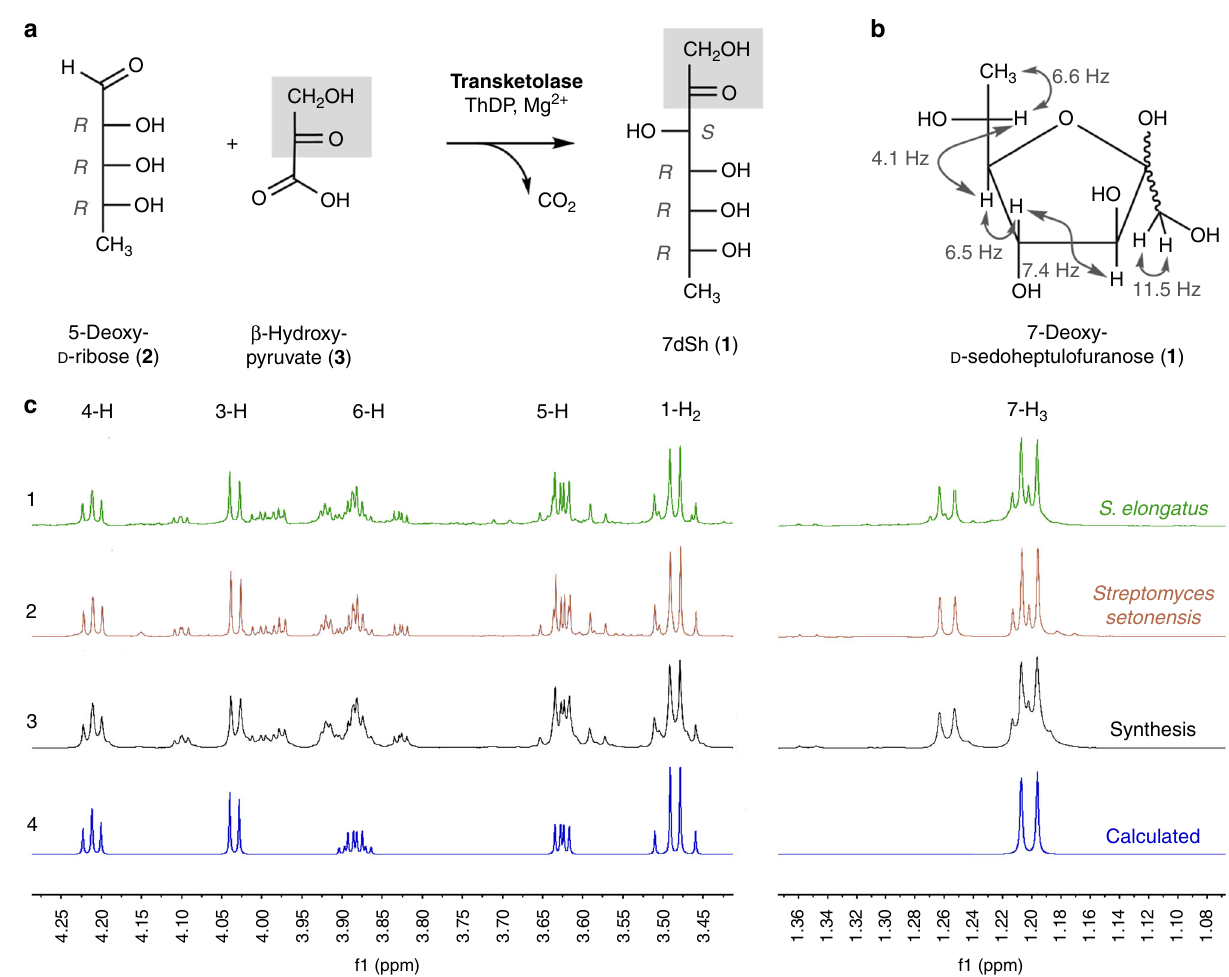
Fig. 2 Structure and chemoenzymatic synthesis of 7-deoxy-sedoheptulose (7dSh, 1 ). a Chemoenzymatic synthesis of 7-deoxy-sedoheptulose (7dSh). Absolute con fi gurations of stereo-centers are indicated. b Chemical structure of 7dSh in the furanose form with given assignments of coupling constants (gray). c (1 – 4) 1 H NMR spectra of 7dSh (CD 3 OD, 600 MHz) chromatographically puri fi ed from supernatants of stationary phase cultures of S. elongatus (1, green), of the puri fi ed 7dSh from the supernatants of Streptomyces setonensis as control (2, red), and of enzymatically synthesized 7dSh (3, black). Predicted from assigned NMR-data (4, blue) of 7dSh in the 7-deoxy- D - altro -heptulofuranose form (Bruker, TopSpin software). Additional proton NMR signals in 1 – 3 give evidence for the dynamic forms of 7dSh in solution (open chain tautomers, ring con fi guration mainly present in the furanose form (Fig. 2b, c).